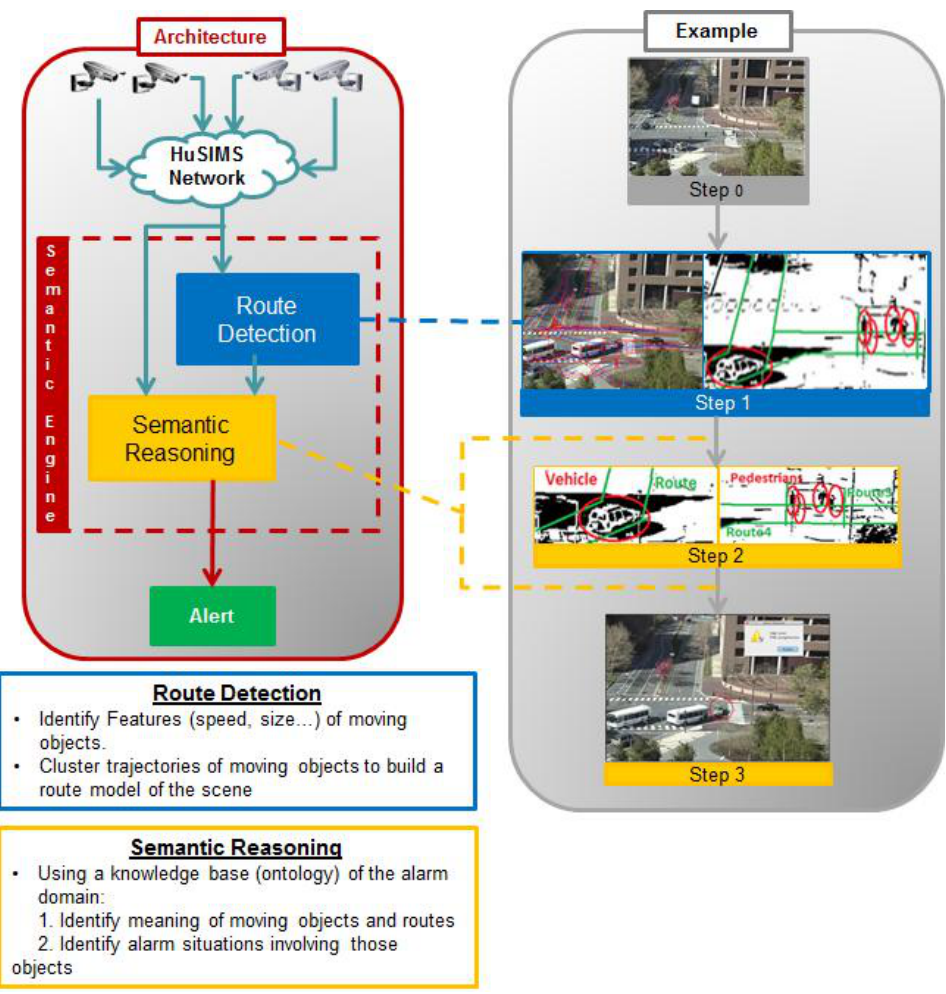
Figure 5. Architecture of Semantic